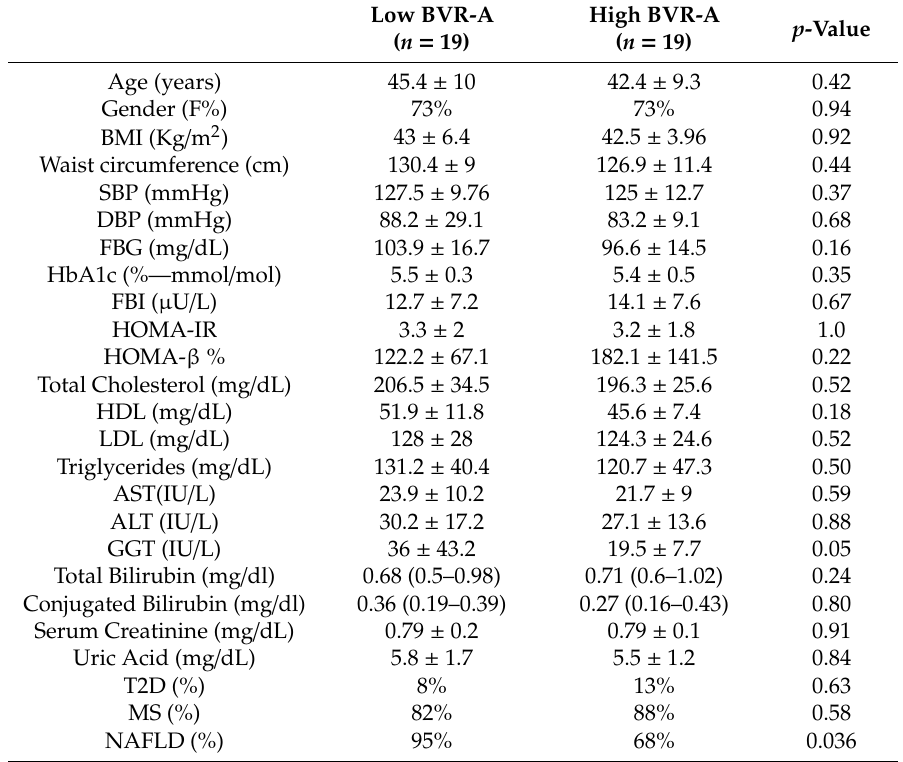
Table 1. Characteristics of the study population in relation to the BVR-A mRNA expression levels in the